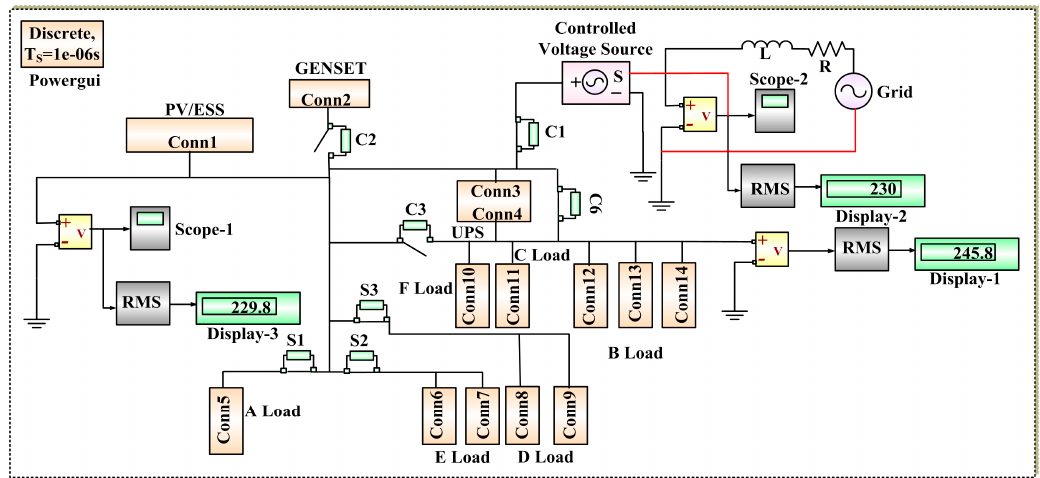
Figure 6. Simulink model of the microgrid system.